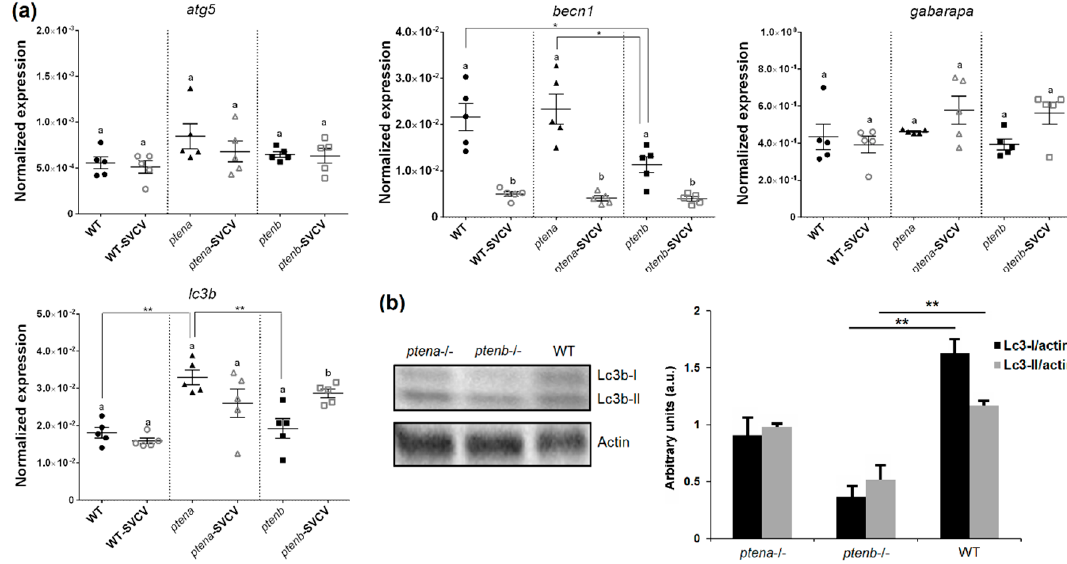
Figure 6. Effect of the pten mutations on the levels of the autophagy-related components. ( a ) Expression of the autophagy-related genes in the different zebrafish lines under healthy and SVCV-infected conditions. The expression of the different genes was normalized to the expression of the 18S ribosomal RNA gene. The graphs represent the means ± SEMs of 5 biological replicates. Statistically significant differences between the uninfected and SVCV-infected individuals from the same zebrafish line are represented with different letters, whereas differences among the zebrafish lines are represented with asterisks as follows: ** (0.001 < p < 0.01) or * (0.01 < p < 0.05). ( b ) Western blot detection of Lc3b-I and Lc3b-II in pools of zebrafish larvae (4 dpf). The graphs represent the means ± SEMs of 5 larvae pools. Statistically significant differences between the zebrafish lines are displayed as ** (0.001 < p < 0.01).